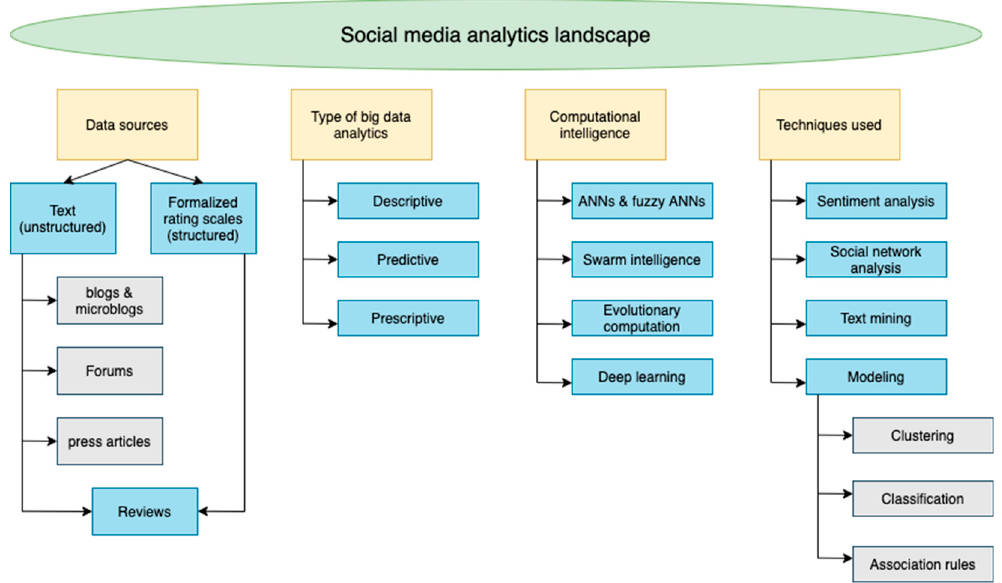
Figure 1. The summary of big data analytics on social media. Source: based on Ghani et al. [99].